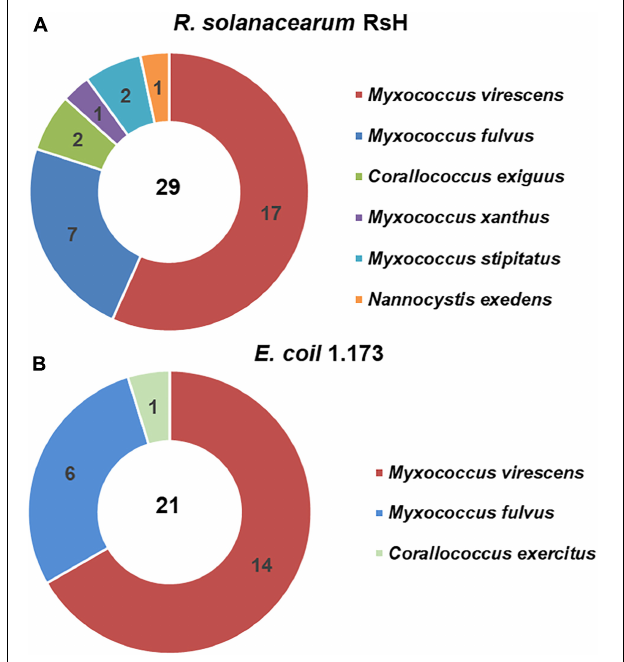
FIGURE 1 | Isolated myxobacteria species from the healthy tomato rhizosphere soil of the tomato bacteria wilt (TBW) field. Using Ralstonia solanacearum RsH (A) and Escherichia coil 1.173 (B) as the prey bacteria, the myxobacteria strains were isolated from the TBW soil sample. The 50 isolates were identified based on the 16S rRNA gene identity analysis. The pie charts showed the species and numbers of the myxobacteria isolates using the two prey